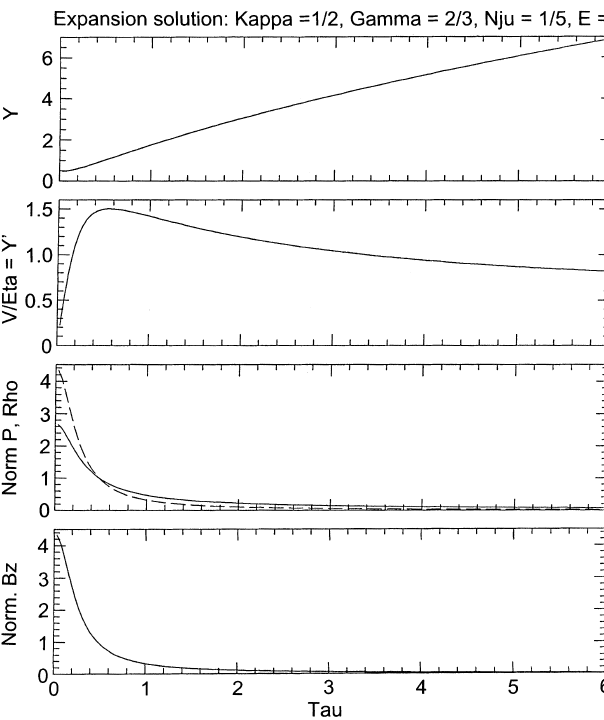
Fig. 3. Numerical MHD solution representing an expanding magnetic flux rope with the same parameters as in Fig. 2. The abscissa represents the normalized time, (cid:115) : From top to bottom , the panels show the evolution function, Y ; the speed of the equivalent one-dimensional system, Y 0 , the normalized gas pressure ( solid curve ) and the normalized plasma density ( dashed curve ) on the axis of symmetry of the flux rope; and, finally, the normalized magnetic field on the axis of